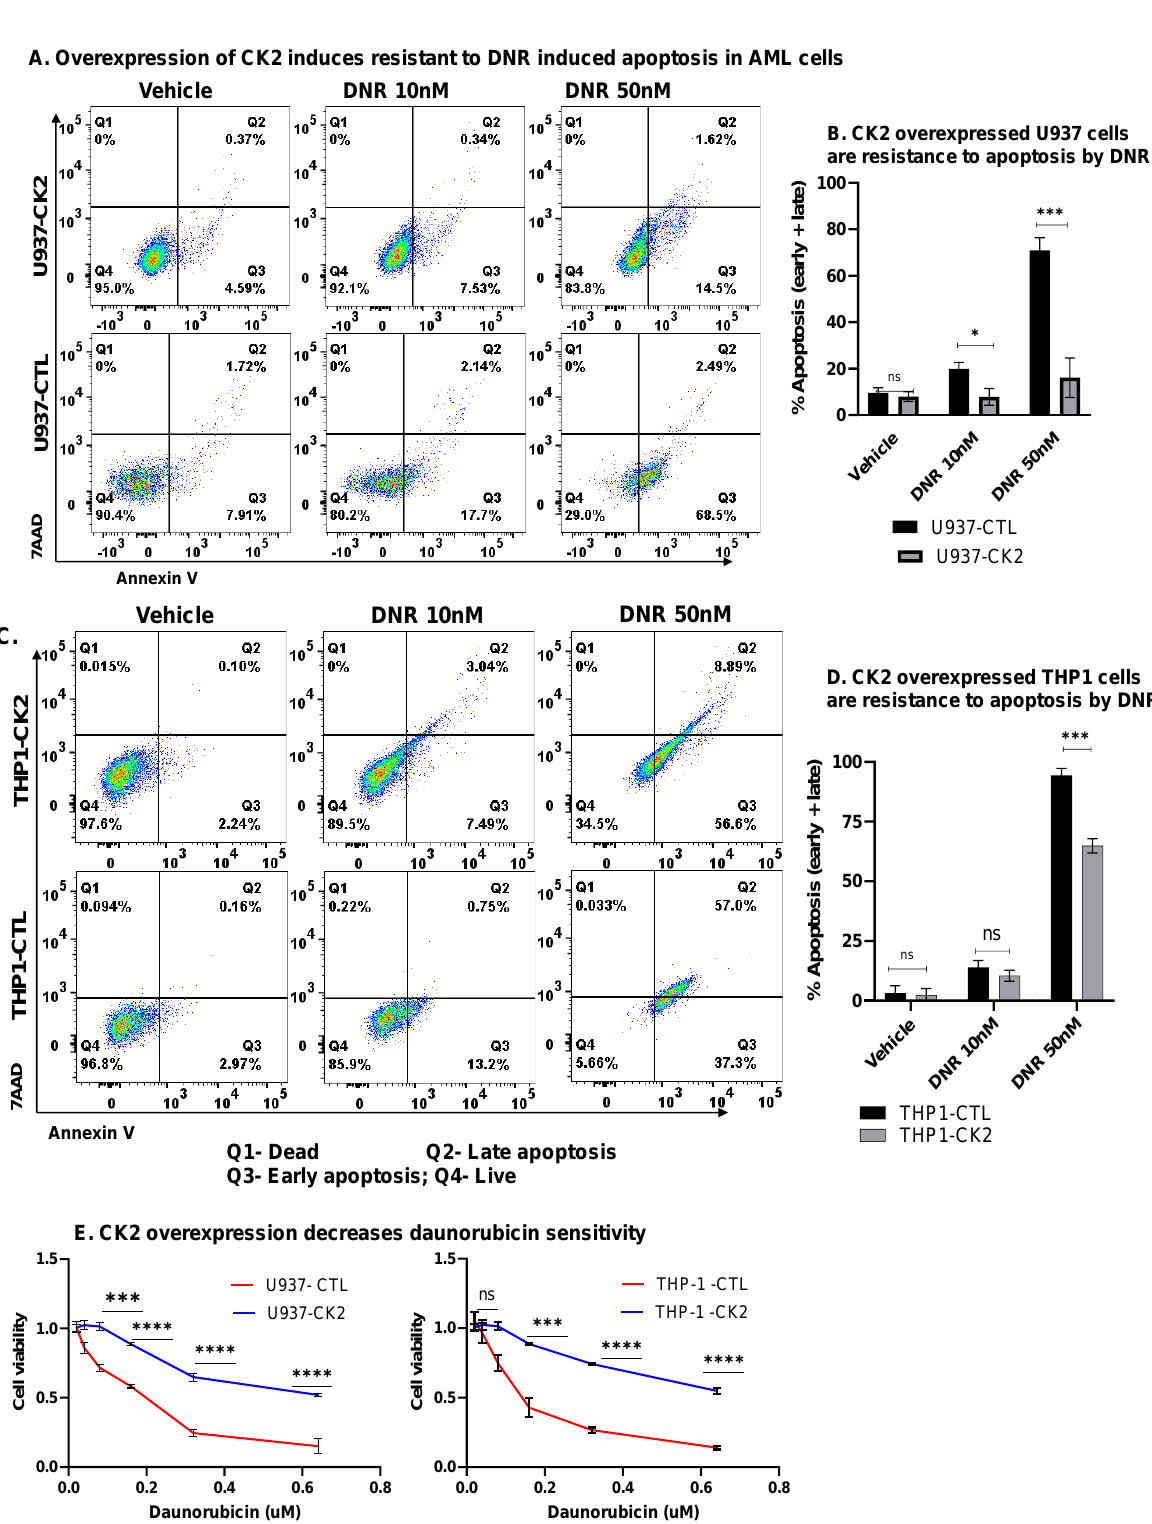
Figure 6. CK2 and IKAROS regulate sensitivity towards daunorubicin. CK2 overexpressing U937 ( A , B ) and THP-1 ( C , D ) were treated with 10 nM or 50 nM of daunorubicin for 48 hand stained with 7-AAD and Annexin V for flow cytometry to determine apoptosis. Flow plots ( A , C ) and percent apoptotic cells (early + late apoptosis) are shown in ( B , D ). Flow plots showing representative results from three replicates. The percentage of cells in the right upper and lower quadrant of each flow chart represents the percentage of late and early apoptotic cells, respectively. Q1-dead, Q2-late apoptosis, Q3-early apoptosis, Q4-live. ( E ) Cytotoxicity and drug response measured by MTT assay after treating CK2 overexpressing U937 and THP-1 cells and respective controls with various concentrations of daunorubicin for 48 h. p > 0.05 (ns); p < 0.05 (*); p < 0.001 (***); p < 0.0001